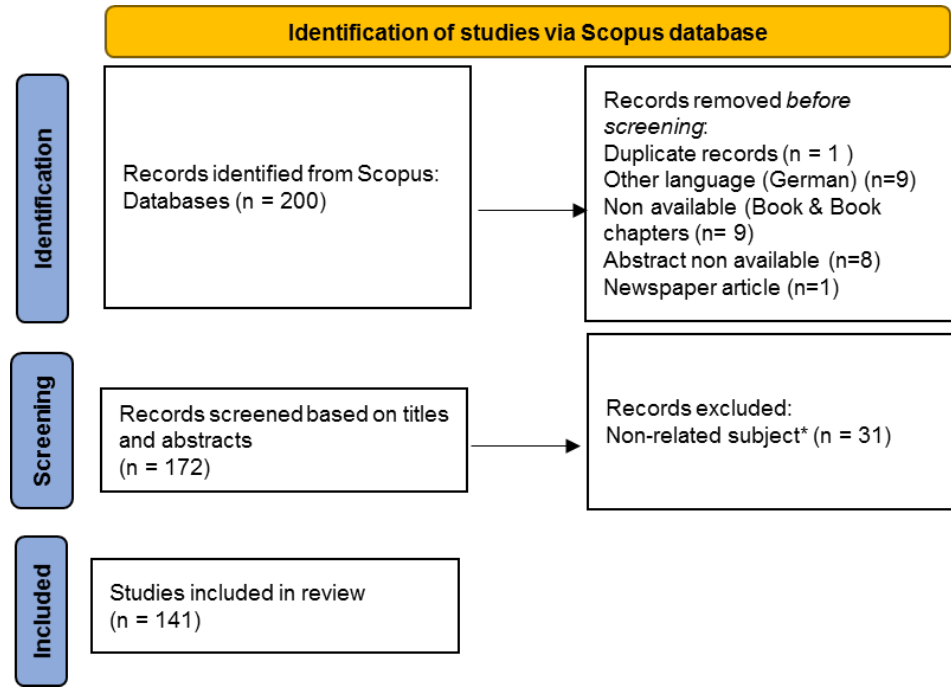
Figure 2. Procedure for the selection of publications. Source: adapted from Page et al. [50]. In the second step, the quantification of each keyword, according to the number of articles using it, was performed. Sorting by the number of times it was used enabled the verification of its relevance, in the scope of the literature on BIDs. In the third step, a new screening of the ordered keywords was carried out to search for similarities between them and to group them, with a twofold objective. The first objective was to consider the relevance of each keyword, within the overall scope of this article goal. Consequently, it was considered that 172 keywords were not related to the study and were excluded. The